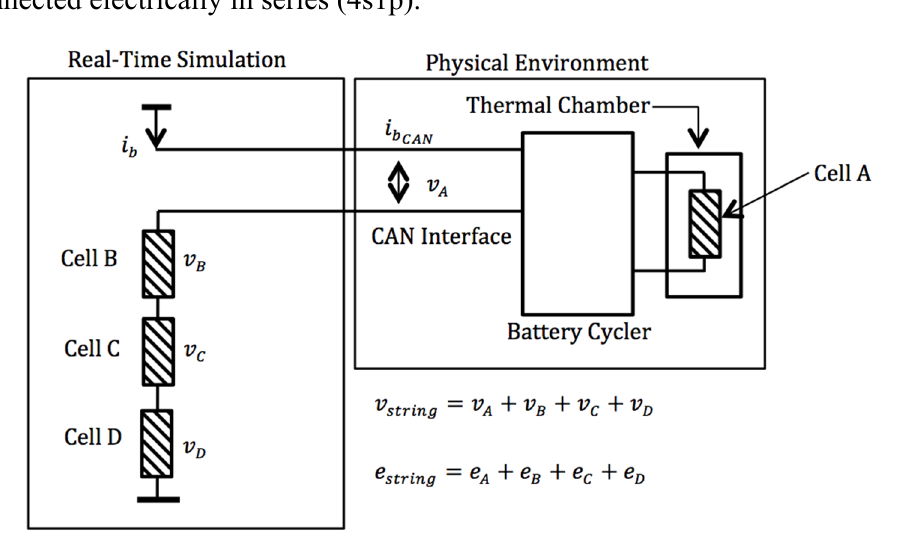
Figure 8. Experimental set-up for the case-study—CILS of four cells in